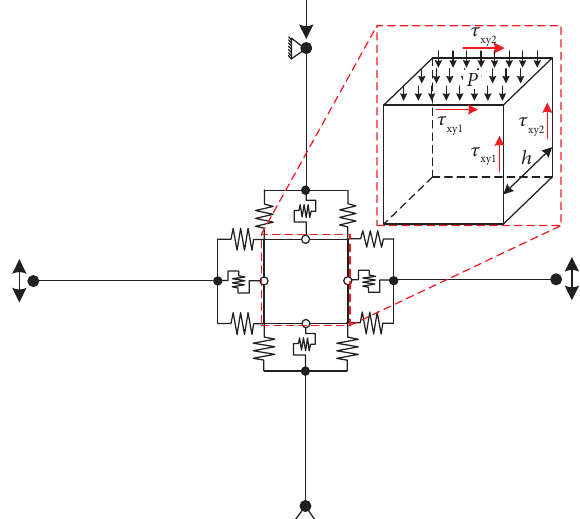
Figure 10: A two-dimensional calculated model of beam-column-